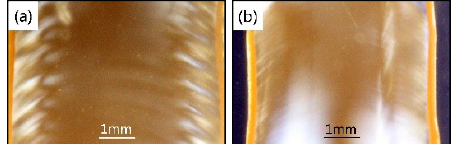
Figure 7. The polarized light images of as-grown Y 2 Ti 2 O 7 slice (sample #7): ( a ) 7 rpm, R = 4.99mm, and ( b ) 15 rpm, R = 3.92mm.